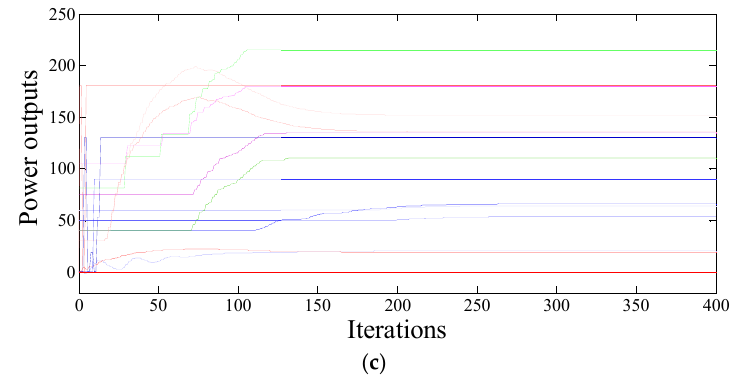
Figure 5. Case study 1, comparison with centralized scheme: ( a ) estimated electrical and heat incremental cost; ( b ) estimated electrical and heat power mismatch; and ( c ) electrical and heat power outputs.